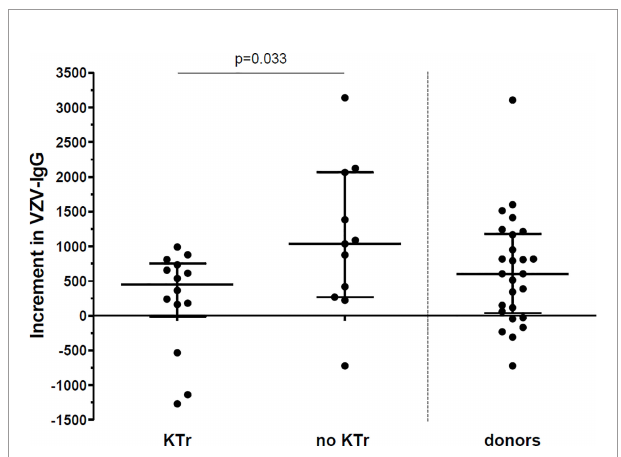
FIGURE 3 | Increment in VZV-IgG titres between vaccination and 12 months after vaccination. Increment in VZV-IgG titres in 14 patients who received a kidney transplant (KTr) within 1 year after vaccination compared to 11 patients who were still on the waitlist (no KTr) at 1 year after vaccination and to 26 donors. Lines indicate median with interquartile